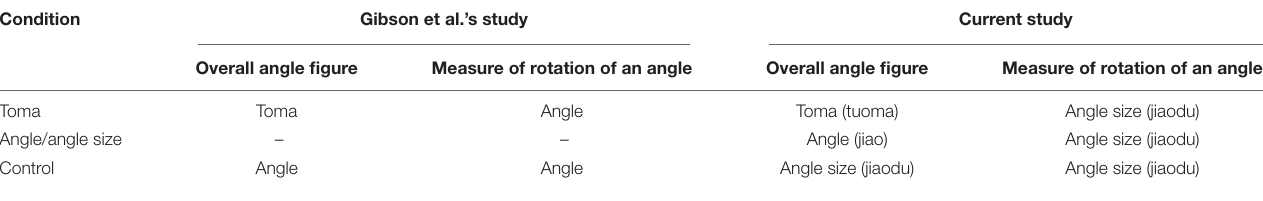
TABLE 2 | The terms used in Gibson et al.’s and current